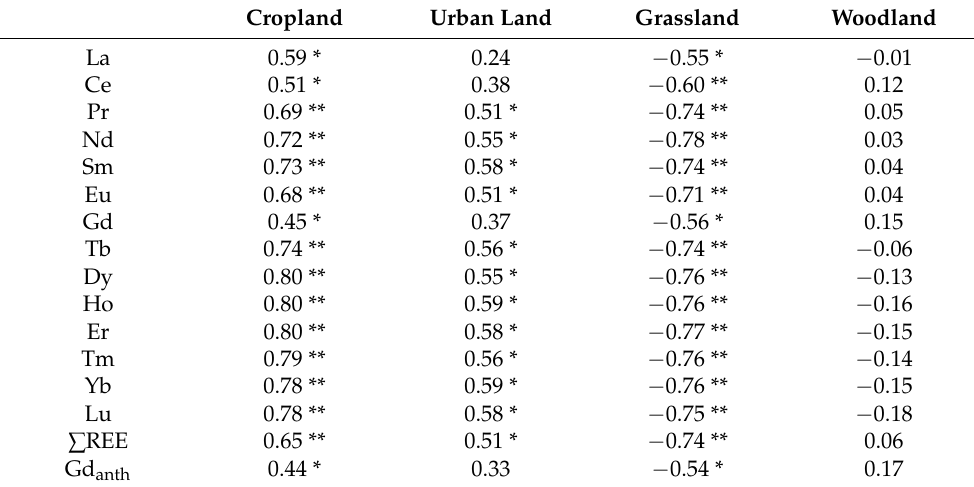
Table 4. Spearman correlations of anthropogenic Gd and REE concentrations with land use in the Yongding River (** p < 0.01; * p < 0.05). Cropland Urban Land Grassland Woodland La 0.59 *